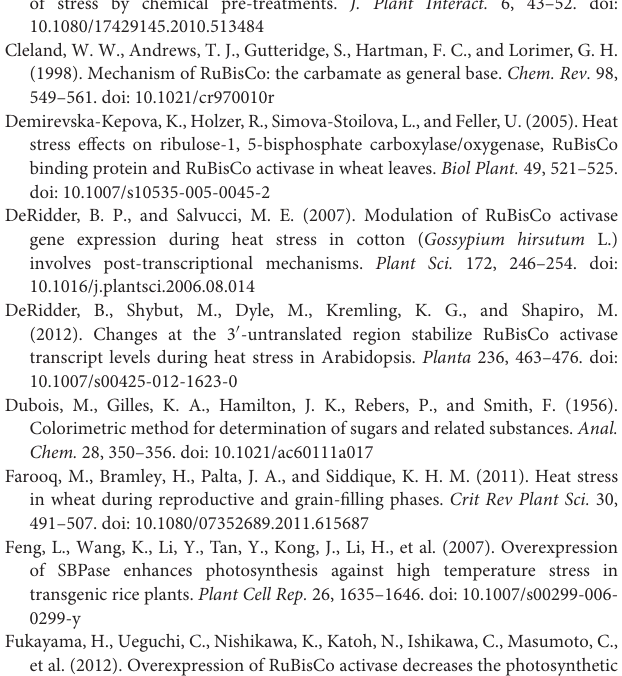
Figure S1 | Work-plan depicting the layout for the sowing, heat shock treatment and samples collection at different stages of growth and development for downstream analysis. Table S1 | List of putative RuBisCo activase genes identified by mining of de novo transcriptome data generated from control and heat shock-treated wheat cv . HD2985 using next-generation sequencing (NGS)